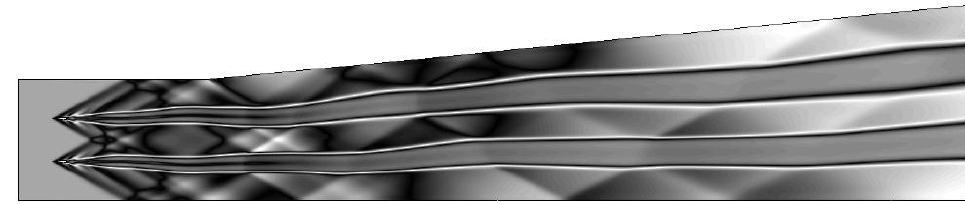
Figure 26. Shock train visualization for twin strut combustor in terms of density (kg/m 3 ).